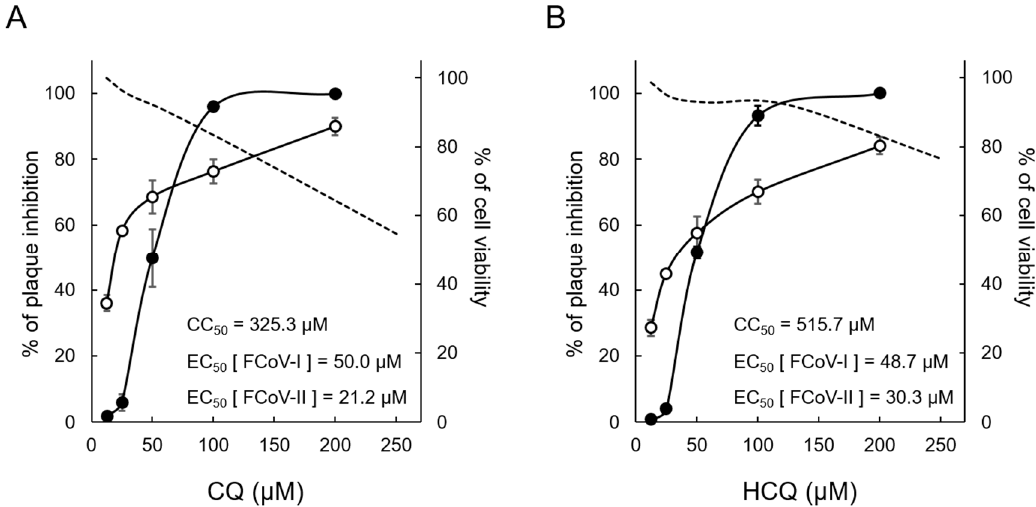
Figure 1. Comparison of the antiviral effects on feline infectious peritonitis virus (FIPV) between chloroquine (CQ) and Hydroxychloroquine (HCQ). CQ and HCQ were separately added to cells at each concentration, and the rate of cell viability was measured after 24 h. In addition, antiviral activities of these drugs were evaluated with regard to the rate of plaque inhibition. ( A ) CQ-treated fcwf-4 cells. ( B ) HCQ-treated fcwf-4 cells. The broken lines represent the rate of cell viability and solid lines represent the rate of plaque inhibition. Black circle: type I FIPV. White circle: type II FIPV. The results are shown as the mean ± SE. Data represent three independent experiments.